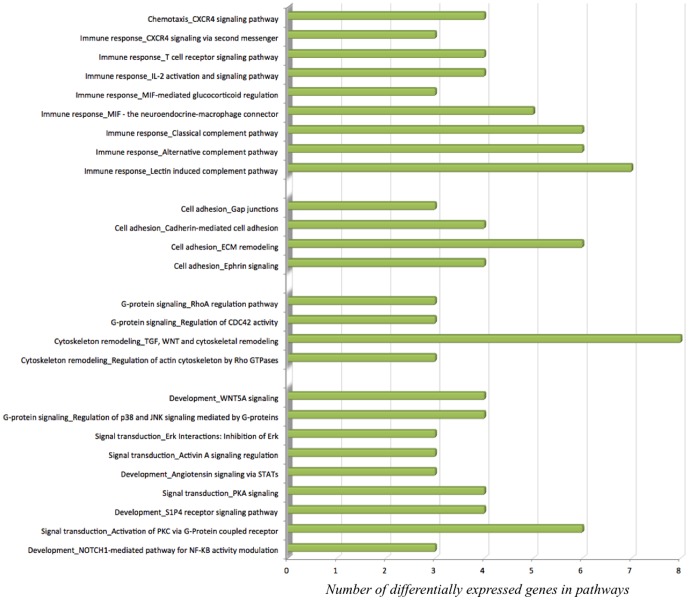
Significant pathways (MetaCore MetaCore Bioinformatics software from Thomson Reuters,https://portal.genego.com/) of the gene expression profiles of leukocytes after consumption of monomeric and oligomeric flavanols (MOF) derived from grape seeds involved in immunity, cell signalling and cell adhesion.